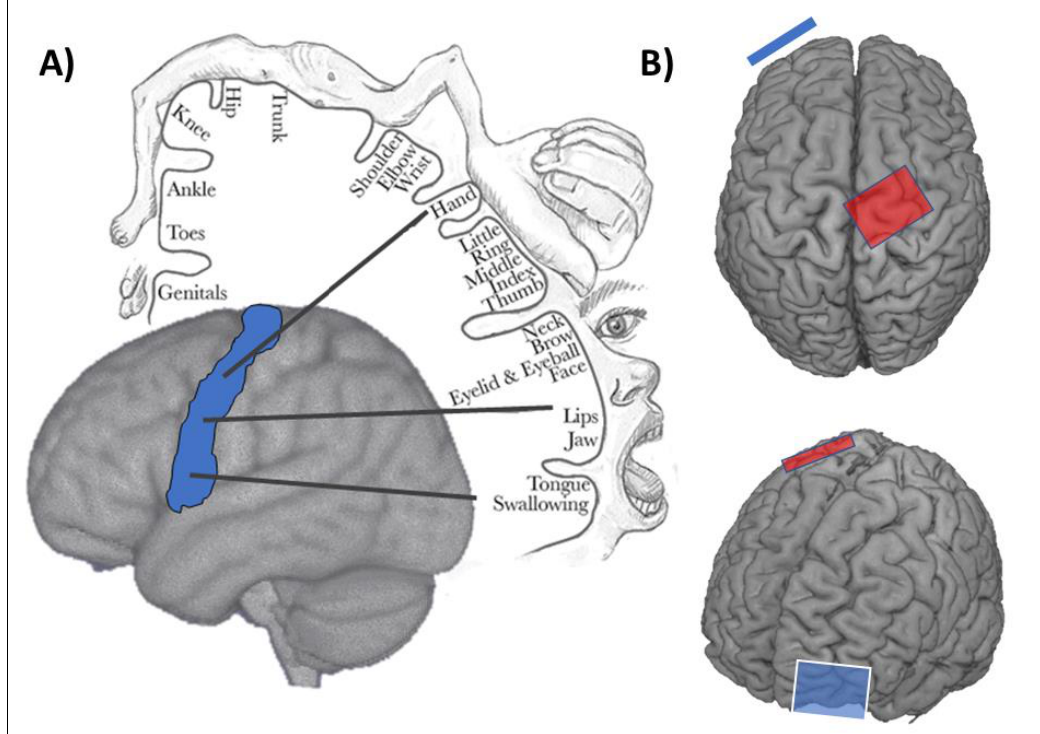
Figure 1. Transcranial direct current stimulation targeting the lower limb motor cortex in humans. ( A ) An example of the motor homunculus in humans. The motor strip on the cortex is highlighted in blue. Note that the lower limb representation is medial and deep within the motor cortex, presenting a challenge to target brain stimulation to this region. ( B ) An example of a standard transcranial direct current stimulation montage for targeting the lower limb motor cortex. The anode is shown in red and approximately overlies the lower limb motor cortex. The cathode (return) electrode is shown in blue and is typically positioned over the contralateral orbital region.